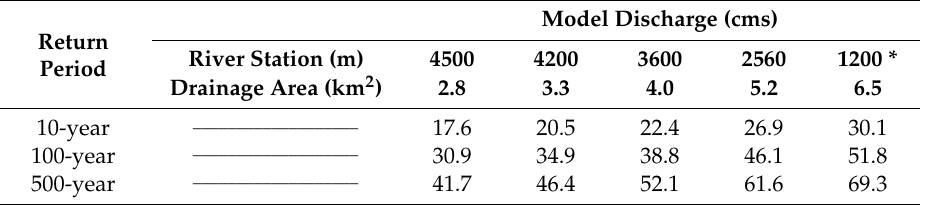
Table 2. Calculated discharge values for return period and flow change location.